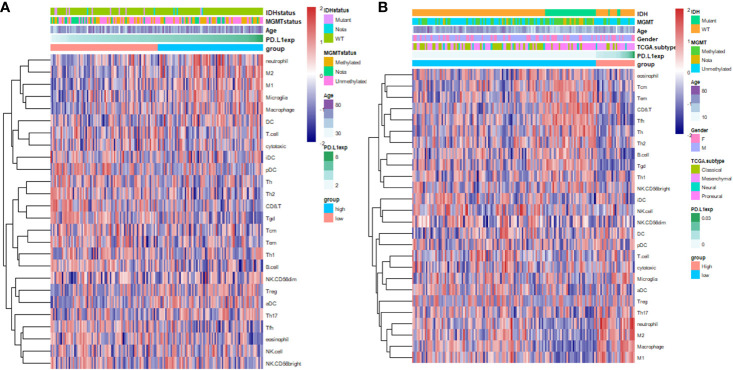
Heatmap indicates the correlation of PD-L1 with 26 immune cell subpopulations in CGGA dataset (A) and TCGA dataset (B). Each coloured square illustrates the correlation between PD-L1 and the transcriptional profile of the corresponding immune cell type. Red colour illustrates a positive correlation (r = 1), white indicates no correlation (r = 0), and blue a negative correlation (r = −1). Immune cells in the ranking list: (A), eosinophil, Tcm, Tem, CD8+T cell, Tfh, Th, Th2, B cell, Tgd (γδT cell), Th1, NK CD56bright cell, iDC, NK cell, NK CD56dim cell, DC, pDC, T cell, Cytotoxic T cell, Microglia, aDC, Treg, Th17, neutrophil, M2-like-Macrophage, Macrophage,M1-like-Macrophage; (B), neutrophil, M2-like-Macrophage, M1-like-Macrophage, Microglia, Macrophage, DC, T cell, Cytotoxic T cell, iDC, pDC, Th, Th2, CD8+T cell, Tgd, Tcm, Tem, Th1, B cell, NK CD56dim cell, Treg, aDC, Th17, Tfh, eosinophil.